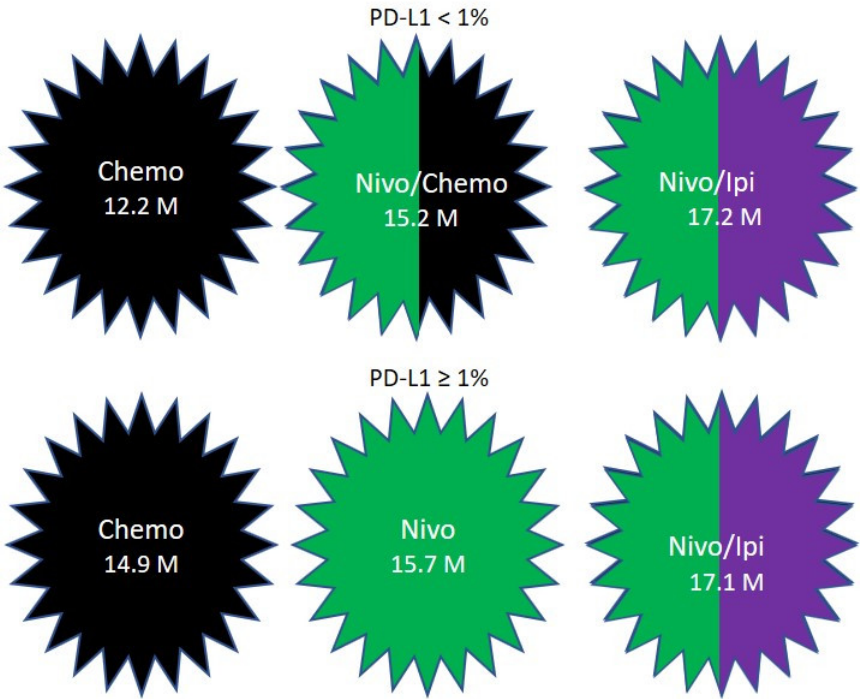
Figure 4. Overall survival results in CHECKMATE-227.